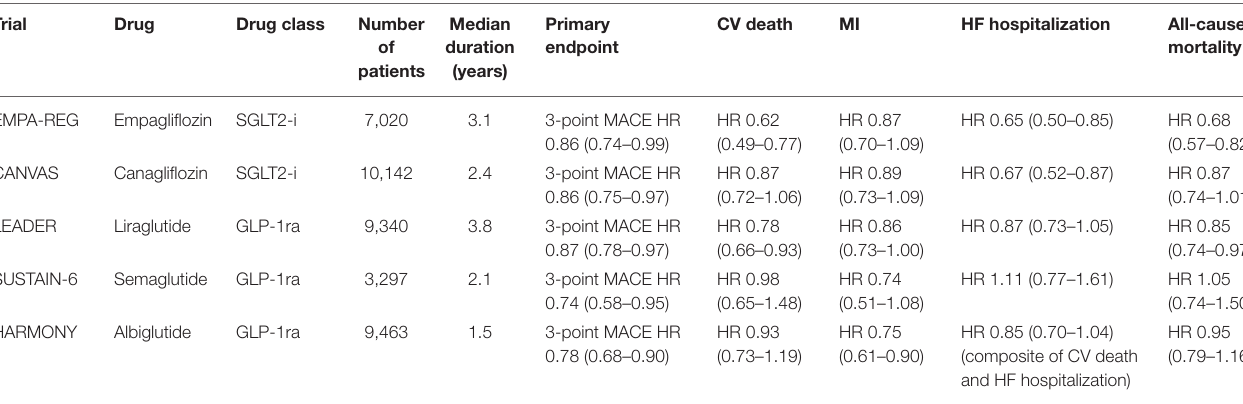
TABLE 2 | Cardiovascular outcomes in select